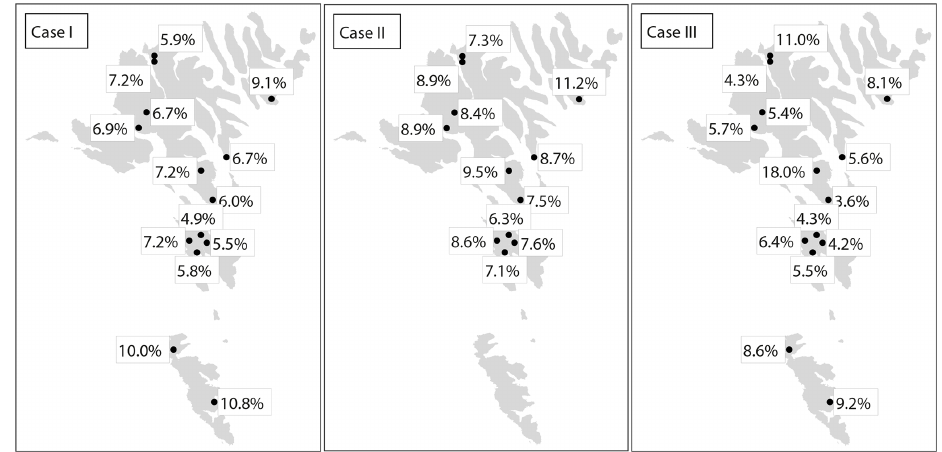
Figure 4. Optimized wind farm configurations, shown in percentages of site-specific wind power capacity per total installed wind power capacity. Case I: considering all 14 favorable wind farm locations selected by Magnussen (2017). Case II: excluding the two southernmost sites. Case III: setting site-specific lower and upper boundaries for the wind farm capacities at the 14 sites. The maps of the terrain are created using a 10m raster map extracted from https://www.foroyakort.fo/ (last access: 16 October 2022), created in Denmark from satellite data from 2017.